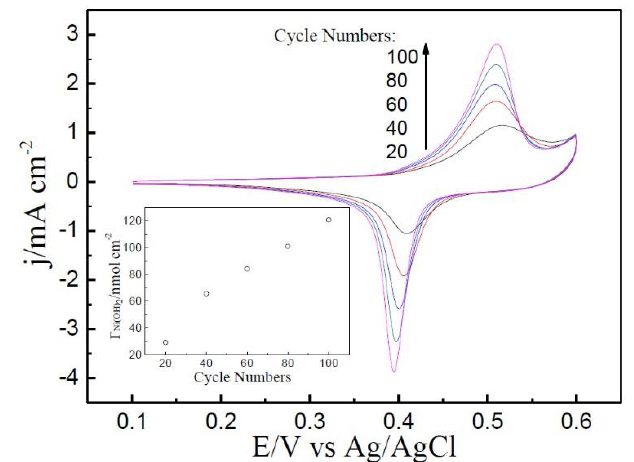
Figure 1. Cyclic voltammograms of the Ni electrode in 1 mol L − 1 KOH under di ff erent potential cycles, inset: loadings of nickel hydroxide as a function of oxide-growth-cycle numbers.